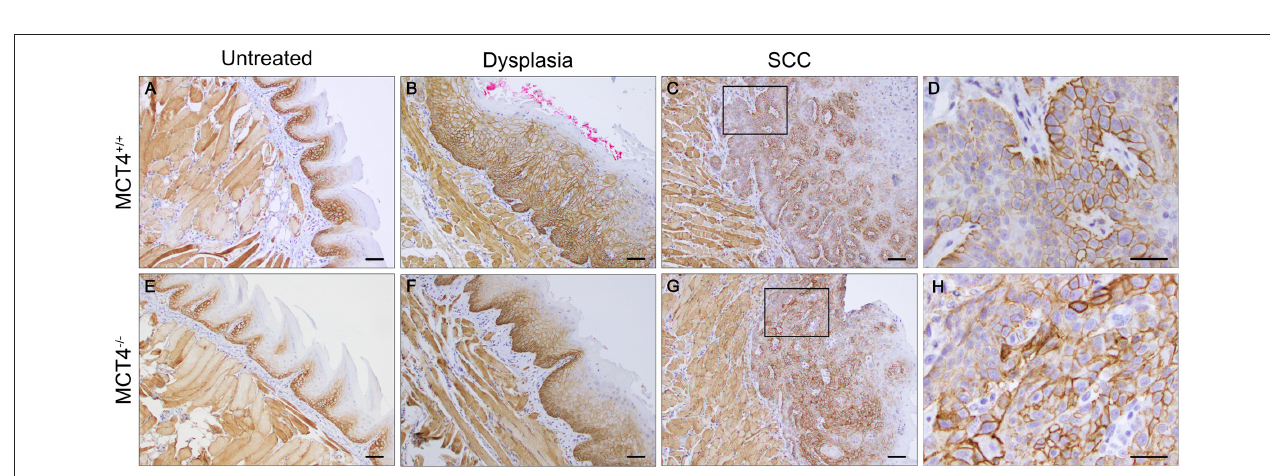
FIGURE 4 | MCT4 is expressed at different stages of oral cancer. Frozen sections of tongues from 4NQO treated wild type mice. MCT4 staining is detected in the basal and suprabasal epithelial layers and in the stroma ( A , magnified in B ), in papilloma ( C , magnified in D ) after 14 weeks of treatment; and in the upper squamous epithelium of carcinoma in situ ( E , magnified in F ) and in both the epithelium and stroma of invasive cancer ( G , magnified in H ) at the 23 weeks timepoint. Scale bar: 100 µ m (A , C , E , G) or 20 µ m (B , D , F , H) .